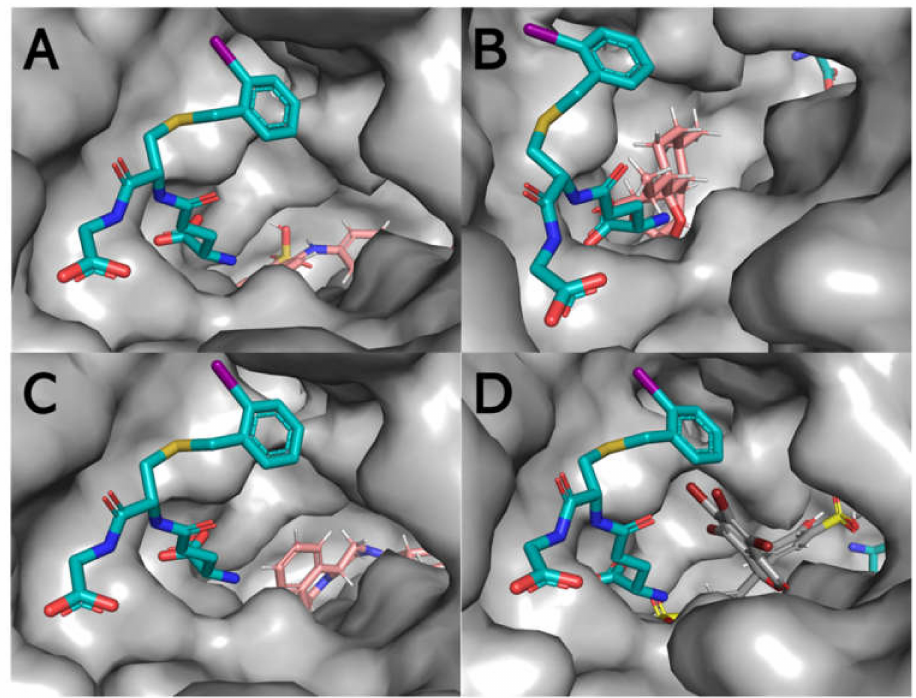
Figure 10. Surface representation of the active site of one of the subunits displaying the binding of hydrophobic molecules, in particular, ANS ( A ), ART ( B ), PZQ ( C ), and BSP ( D ) concerning the position of the γ -glutamyl[S-(2- iodobenzyl)cysteinyl]glycine (cyan stick formation) ligand, which makes contact with both the G-site and the H-site. ANS, ART, PZQ, and BSP appear to reside primarily within the L-site of the structure. The image was generated using PyMOL (PDB: